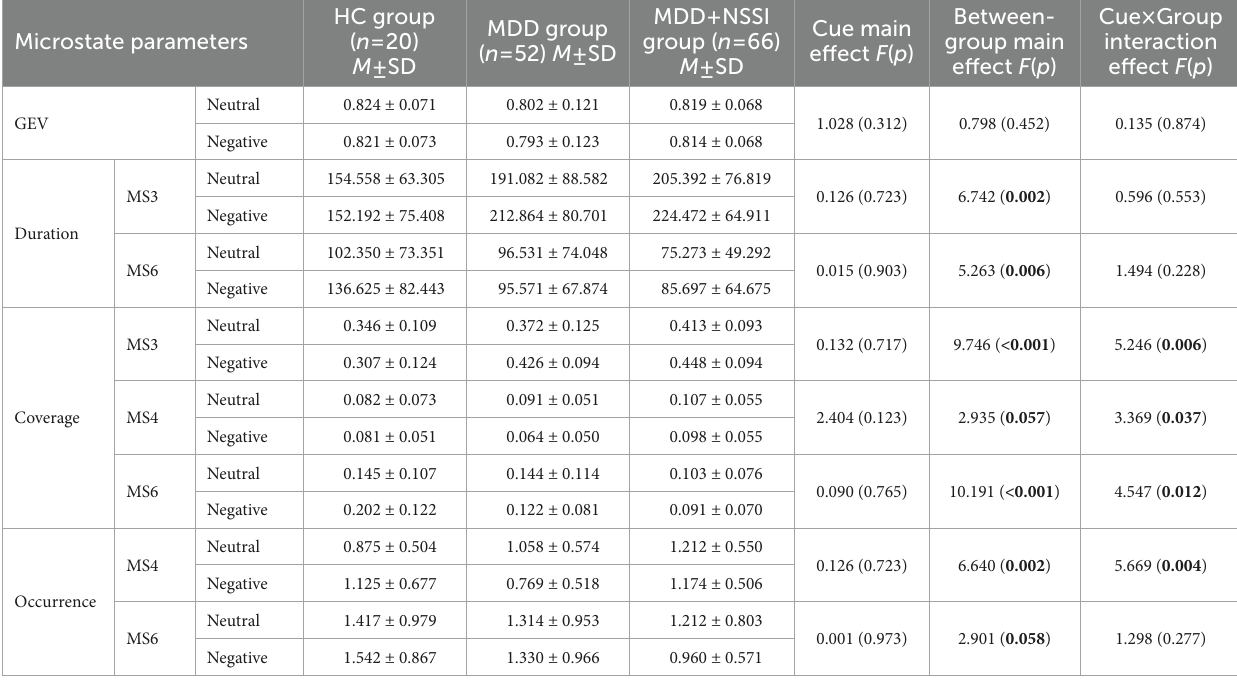
The bolded p values indicate statistical significance. We bolded for greater